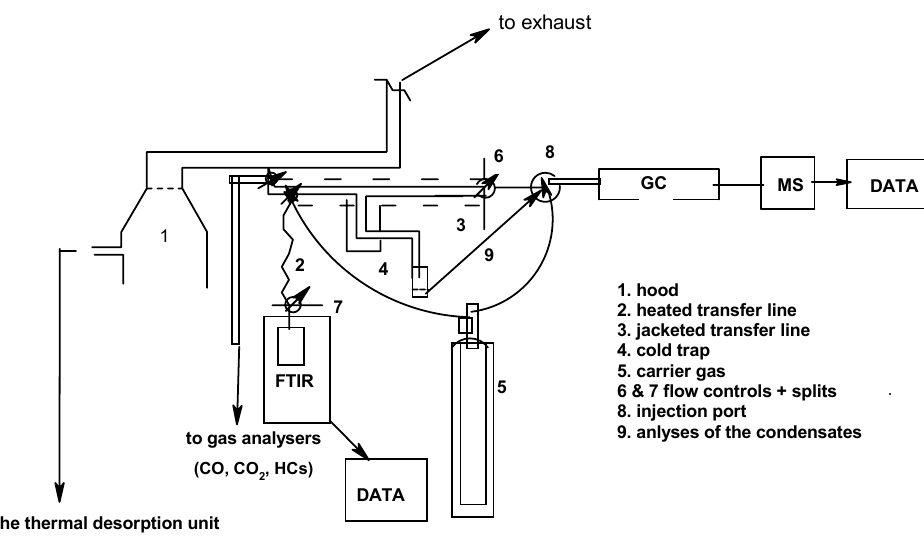
Figure 5. Indicative experimental set-up for evolved gas